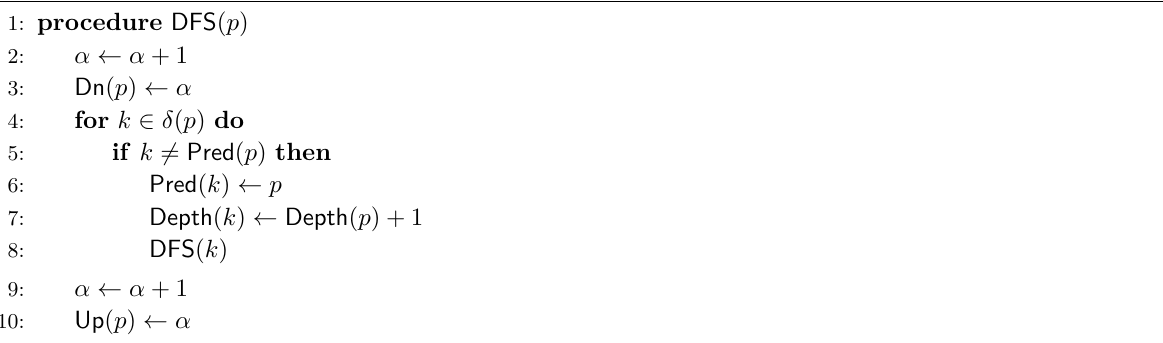
Algorithm 2 The recursive procedure to visit T ∗ in depth-first-search